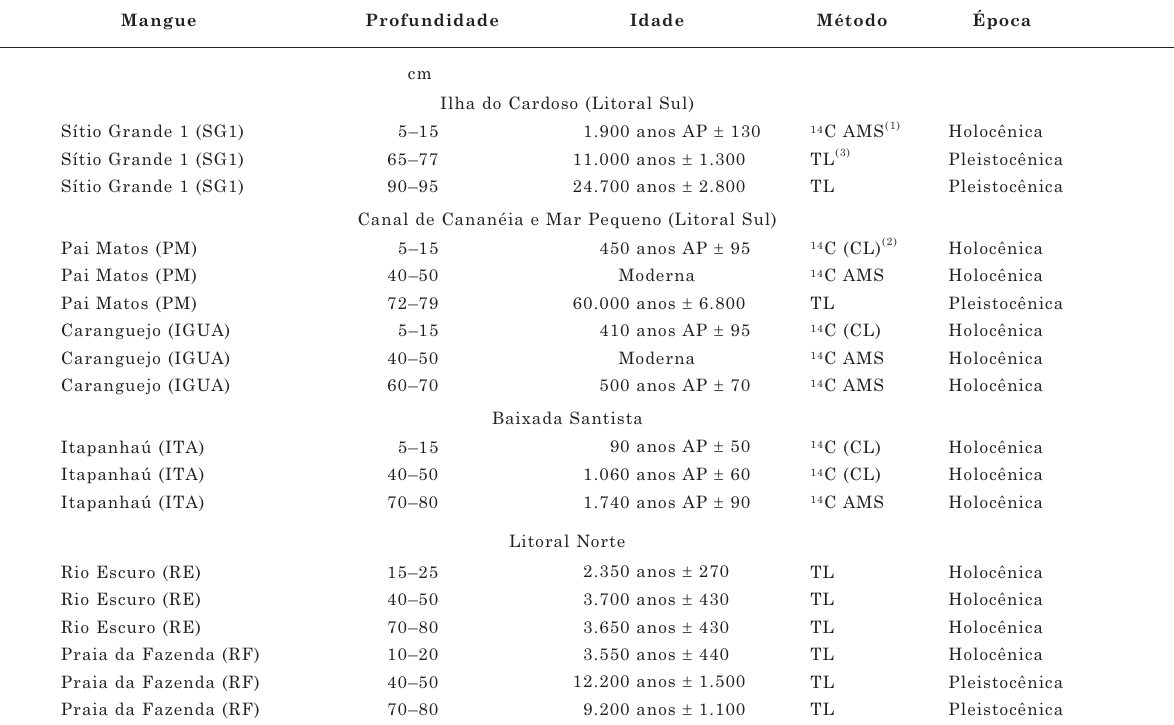
(1) Datação radiocarbônica por espectrometria de aceleração de massa. (2) Datação radiocarbônica por cintilação líquida. (3) Datação por